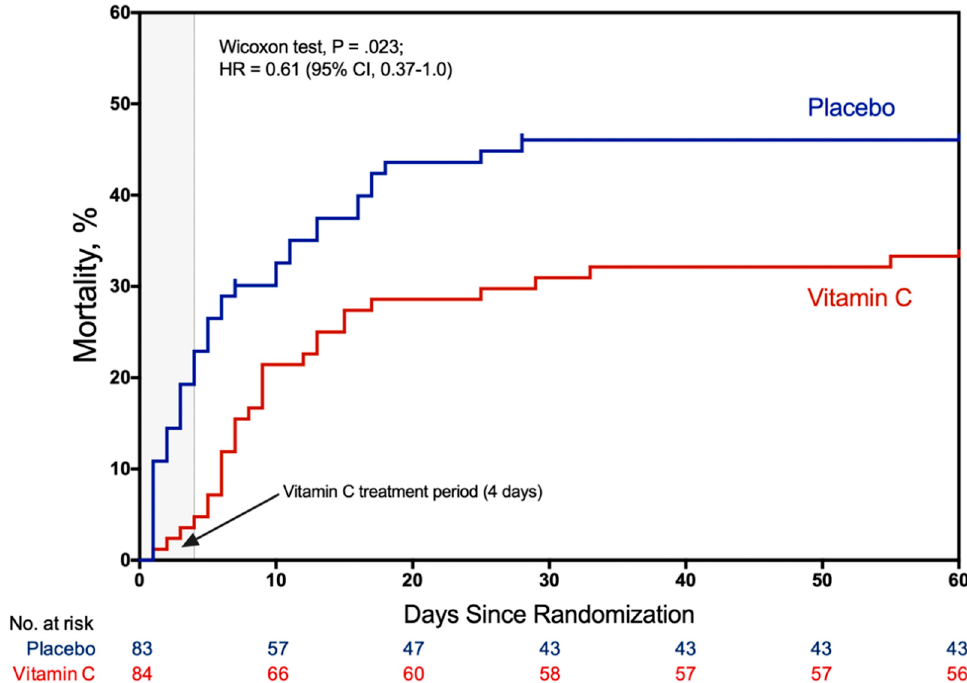
Figure 5. Kaplan–Meier mortality curves in patients with sepsis induced acute respiratory distress syndrome (ARDS) who were randomized to receive a 4-day course of high-dose intravenous vitamin C (HDIVC) versus placebo, upon ARDS onset-recognition.